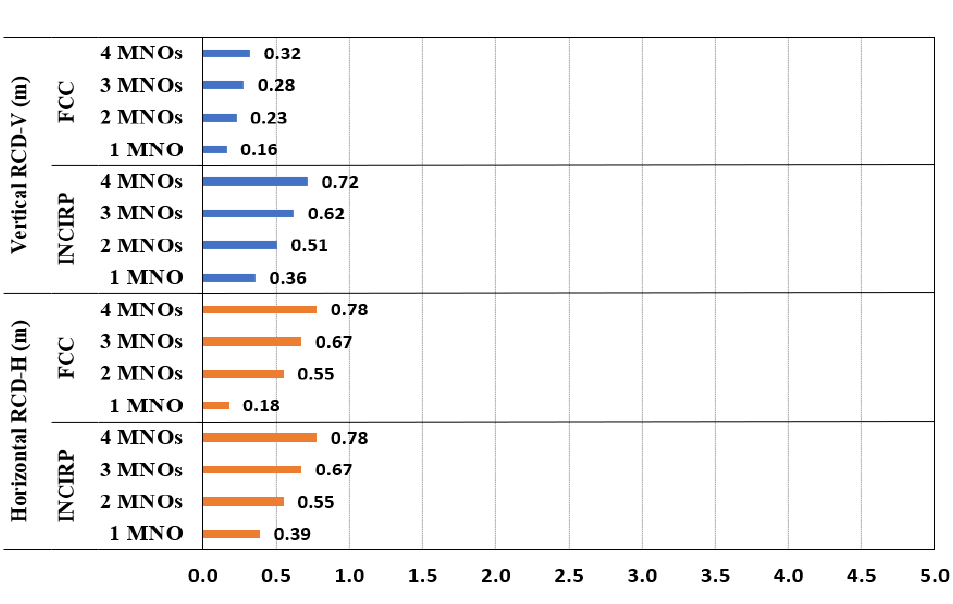
Table 4. Configuration setup for shared indoor IBS.